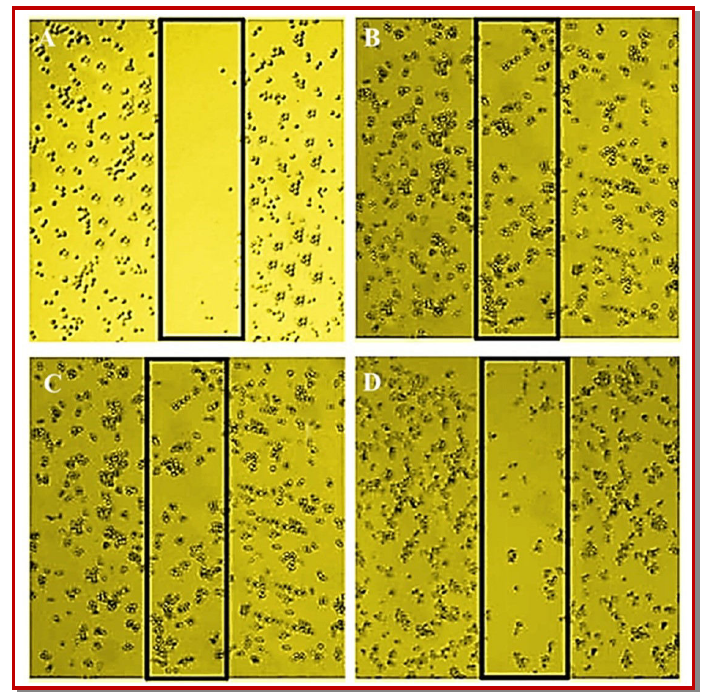
Figure 6: Inhibitory effects of theaflavin-3-gallate on the migration of A-549 cells. (A) Initial view of scratch at time 0, before any drug treatment, (B) control, after 24 hours, (C) theaflavin-3-gallate-treated cells at 24 hours at a dose of 80 µM, and (D) theaflavin-3- gallate-treated cells at 24 hours at a dose of 160 3-gallatedistinctly reduced A-549 cell migration in a concentration dependent manner. Figure 6A represents untreated (0 µM) control cells while Figure 6B, C and D represent effect of 20, 80 and 160 µM dose of theaflavin- 3-gallate respectively. Treatment of the cells with theaflavin- 3-gallate led to a decrease in the rate at which the cells migrate into the clear area created by scratch.